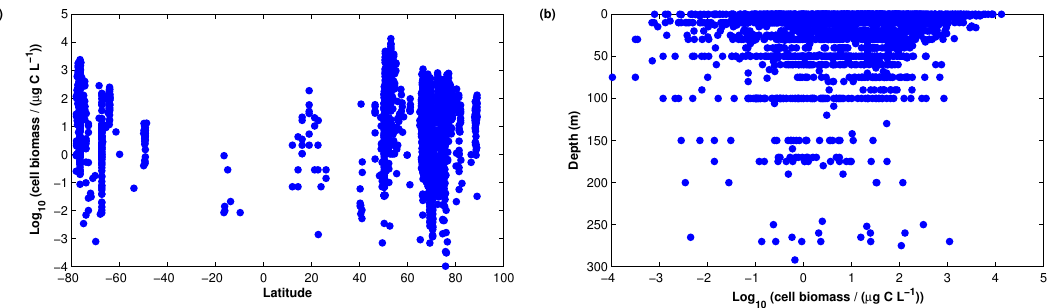
Figure 6. Distribution of non-zero log-normalized Phaeocystis cell biomass ( µ gCl − 1 ) (a) as a function of latitude and (b) as a function of Fig. 6. Distribution of non-zero log-normalized Phaeocystis cell biomass (µg C l − 1 ) (a) as a function of depth. latitude and (b) as a function of depth.